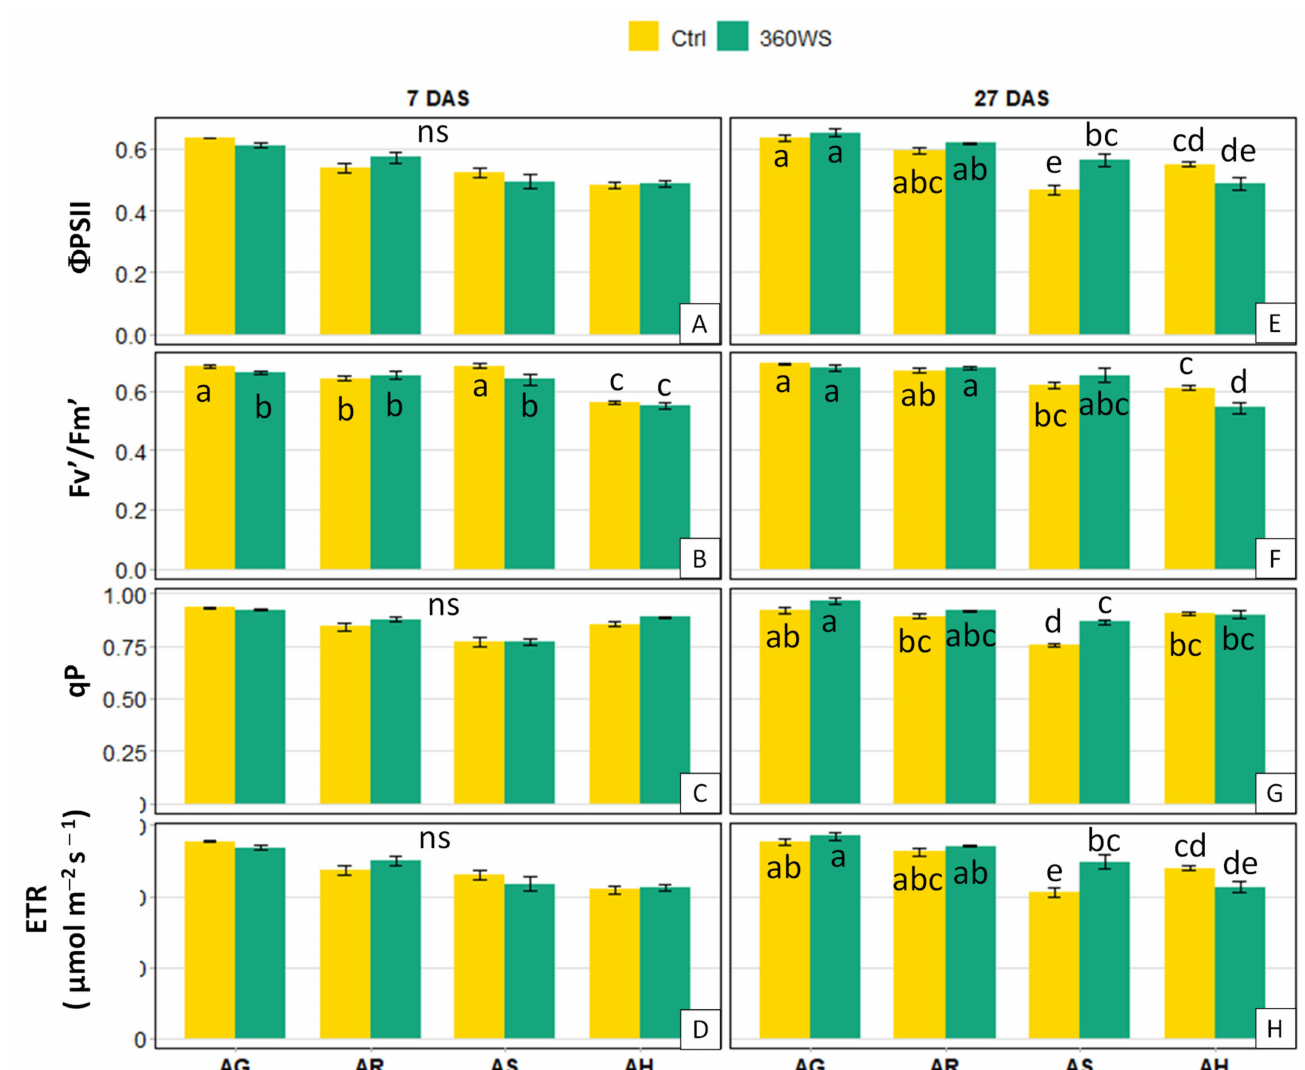
Figure 3. Operating efficiency of PSII photochemistry ( Φ PSII), maximum efficiency of PSII photochemistry in the light (Fv’/Fm’), level of photochemical quenching of PSII (qP), and electron transport rare (ETR) at 7 days after salt stress initiation ( A , B , C , D , respectively) and at 27 days after salt stress initiation ( E , F , G , H , respectively) under control (Ctrl) and 360 mM water salinity (360 WS) in the four genotypes A. hortensis cv. green (AG), A. hortensis cv. red (AR), A. hortensis cv. scarlet (AS), and A. halimus (AH). Vertical bars indicate standard error ( n = 4). Different letters indicate significant differences at p <